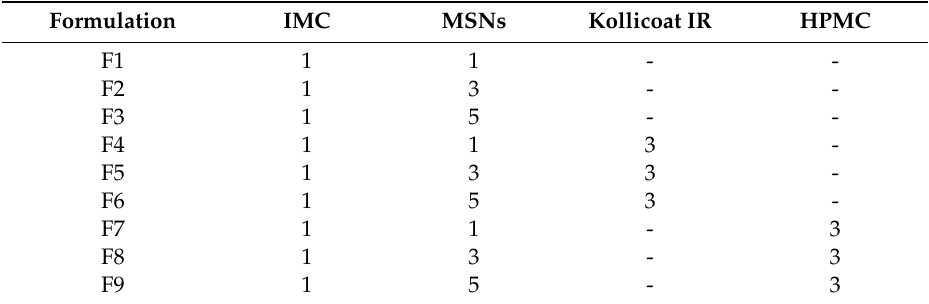
Table 1. Di ff erent ratios (% w / w ratio) of drug and carriers (i.e., polymers and MSNs) of IMC solid dispersions.